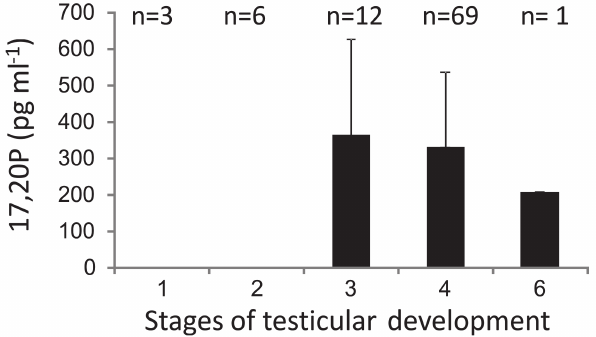
Fig. 4. Plasma level of 17,20ß-P in males at different stages of development sampled at the Río de la Plata estuary. 1: Immature testis; 2: Developing testis (early spermatogenesis); 3: Fully developed testis (whole spermatogenesis), 4: Spermiating testis; 6: Resting testis. n = number of fish collected for each